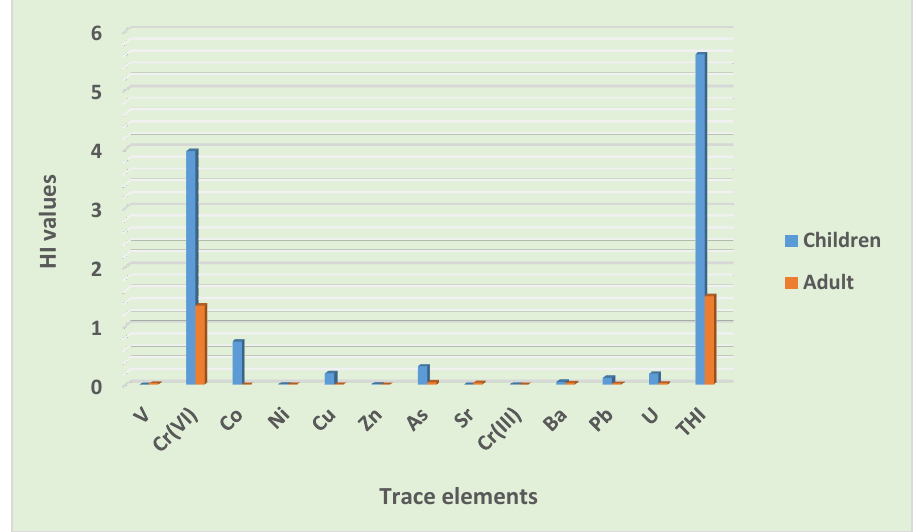
Figure 7. Contribution of trace elements to non-carcinogenic risk.